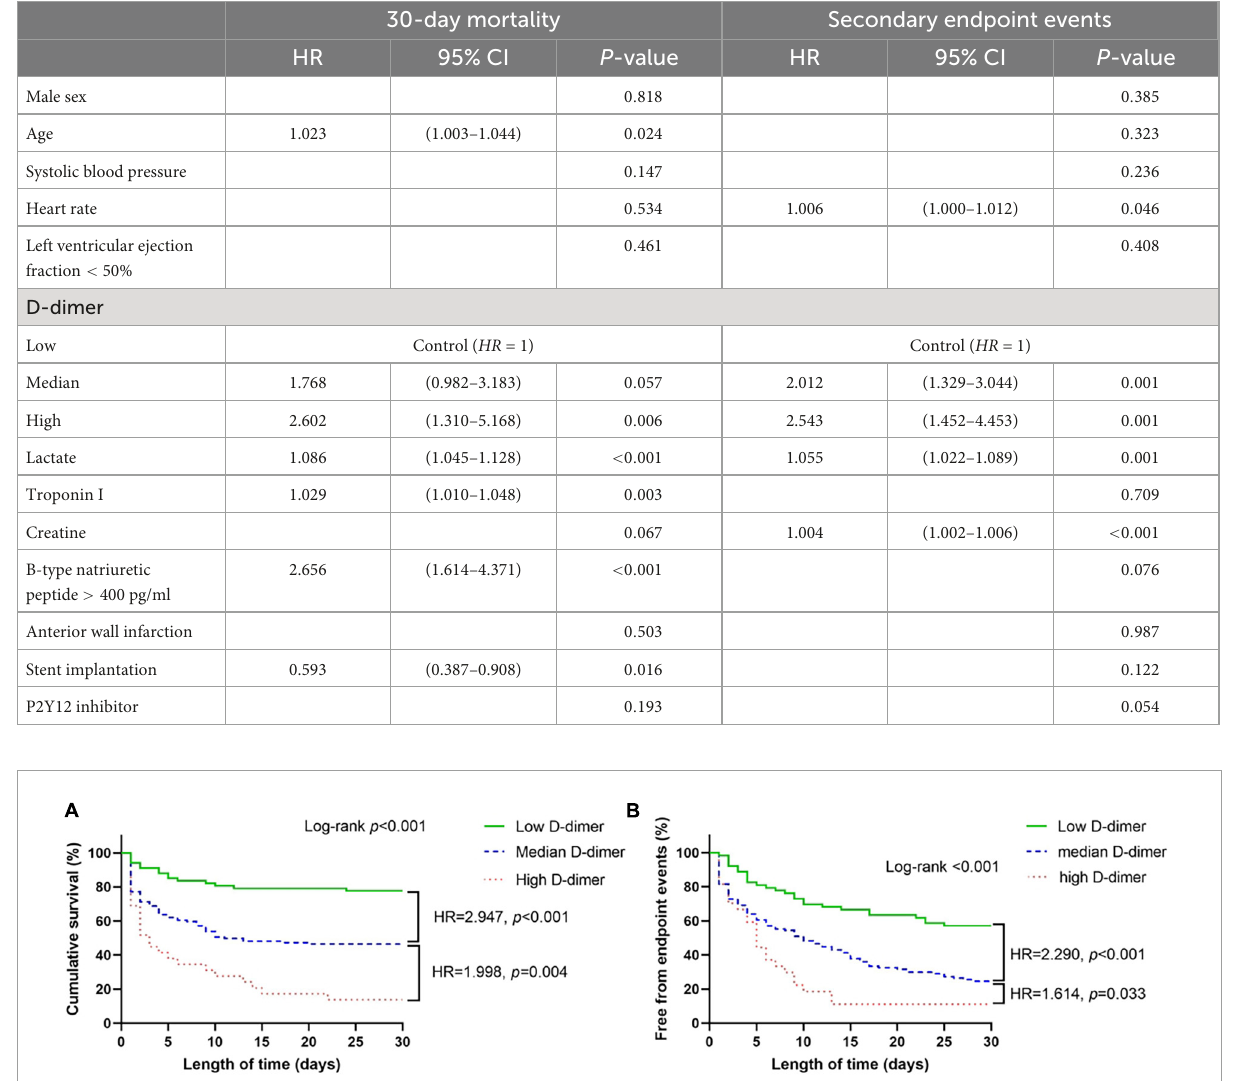
FIGURE2 Continuous hazard ratio across D-dimer (A) and logarithmic D-dimer (B) according to restricted cubic spline analysis. HR = hazard ratio, line = predicted HR, dashed area = 95% confidence